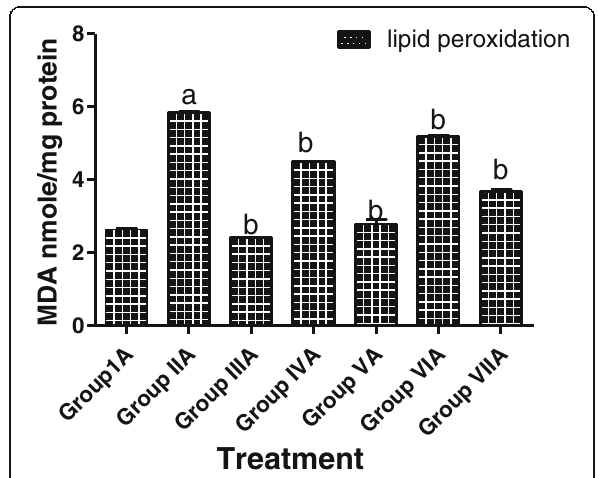
Fig. 4 Effect of methanol extract of T. conophorum seeds on lipid peroxidation levels in CCl 4 induced hepatotoxicity in rats after 24 h of intoxication. Values are Mean ± SEM, n = 5 rats in each group. p < 0.05, a as compared with the normal control group; b as compared with the CCl 4 only (group IIA). CCl 4 , Carbon tetrachloride, MDA- malondialdehyde. Group IA (control) received distilled water and olive oil (i.p), group IIA rats were intoxicated with CCl 4 in olive oil (600 mg/kg, i.p.) only on the 8th day, while groups IIIA, IVA and VA were given 100 mg/kg of silymarin, 250 mg/kg and 500 mg/kg of methanol extract, respectively for 7 days, thereafter intoxicated with CCl 4 on the 8th day. Groups VIA and VIIA were intoxicated with CCl 4 on the 8th day and administered 250 mg/kg and 500 mg/kg of